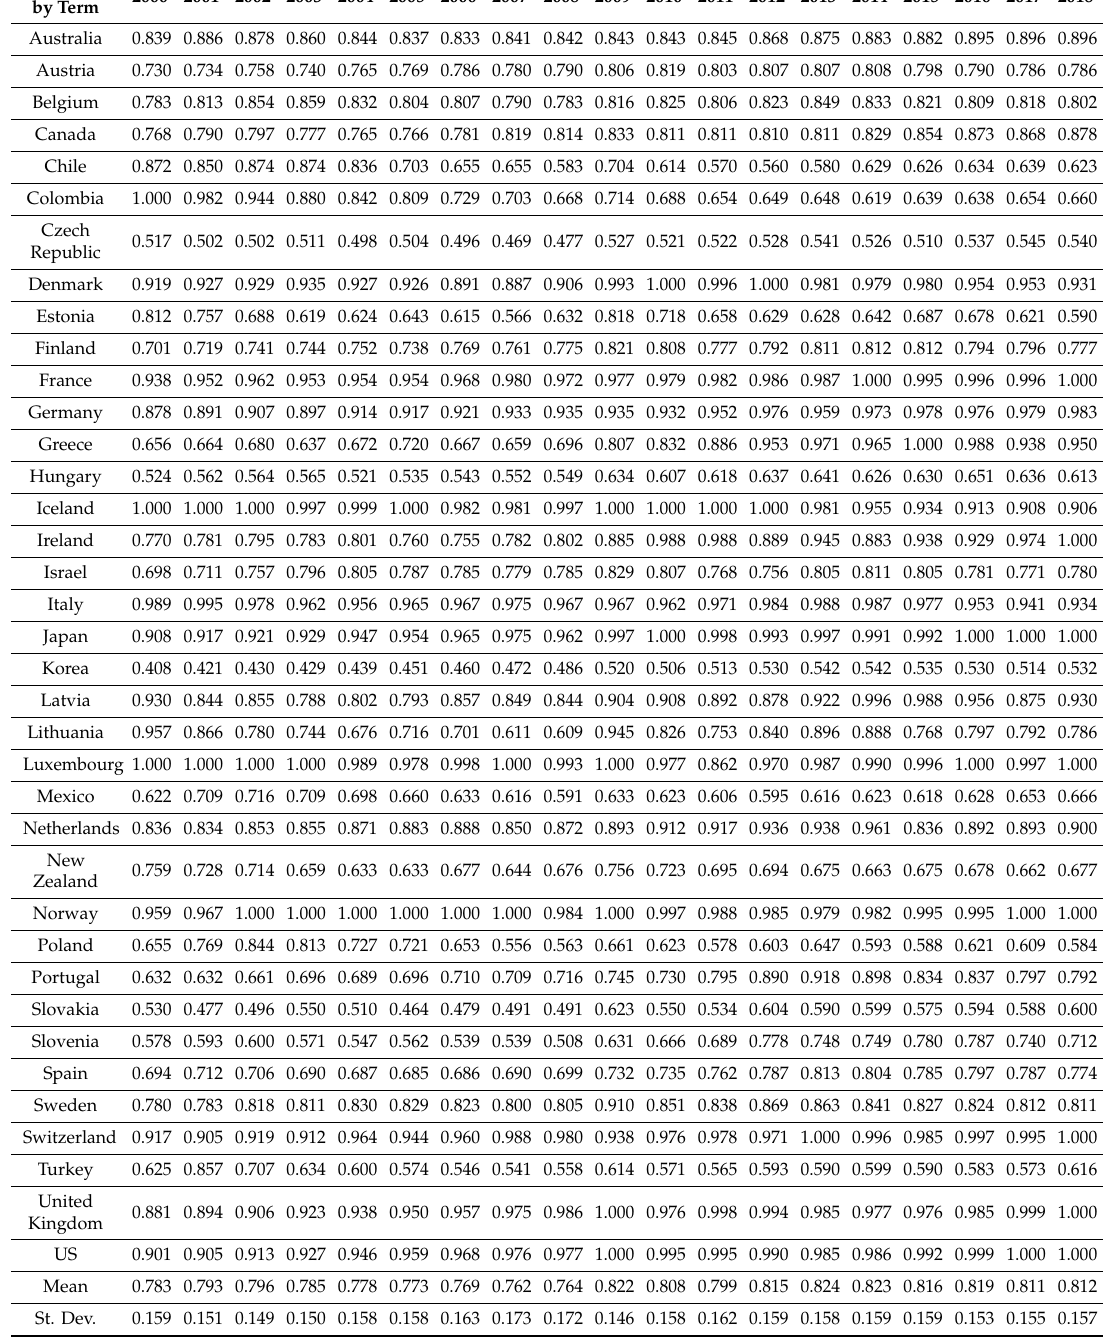
Table 6. Total factor energy e ffi ciency means for 10-year window ( w =